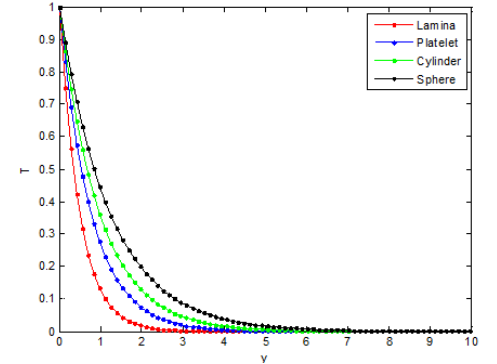
Figure 10. Effects of nanoparticle shape on temperature distribution of